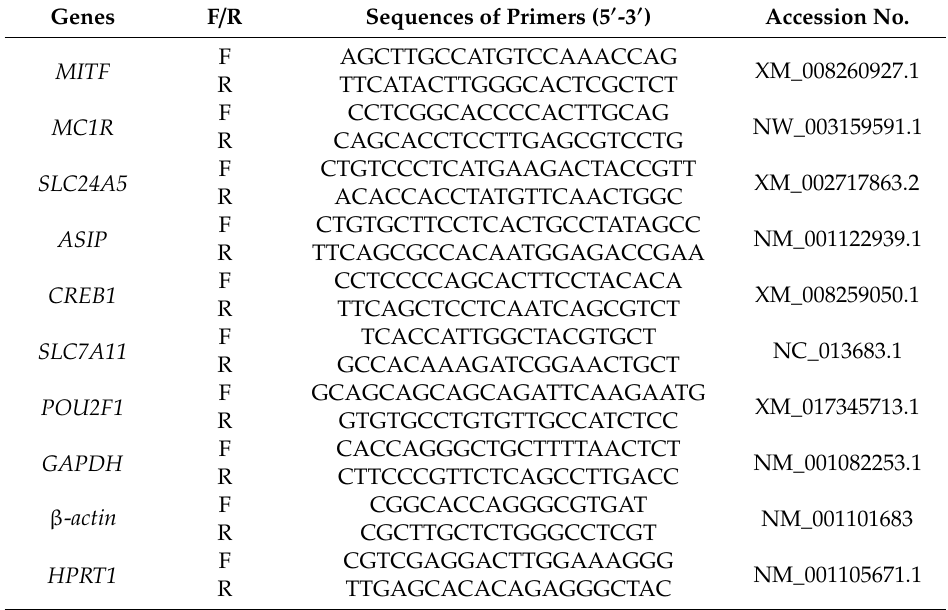
Table 1. Primer sequences for